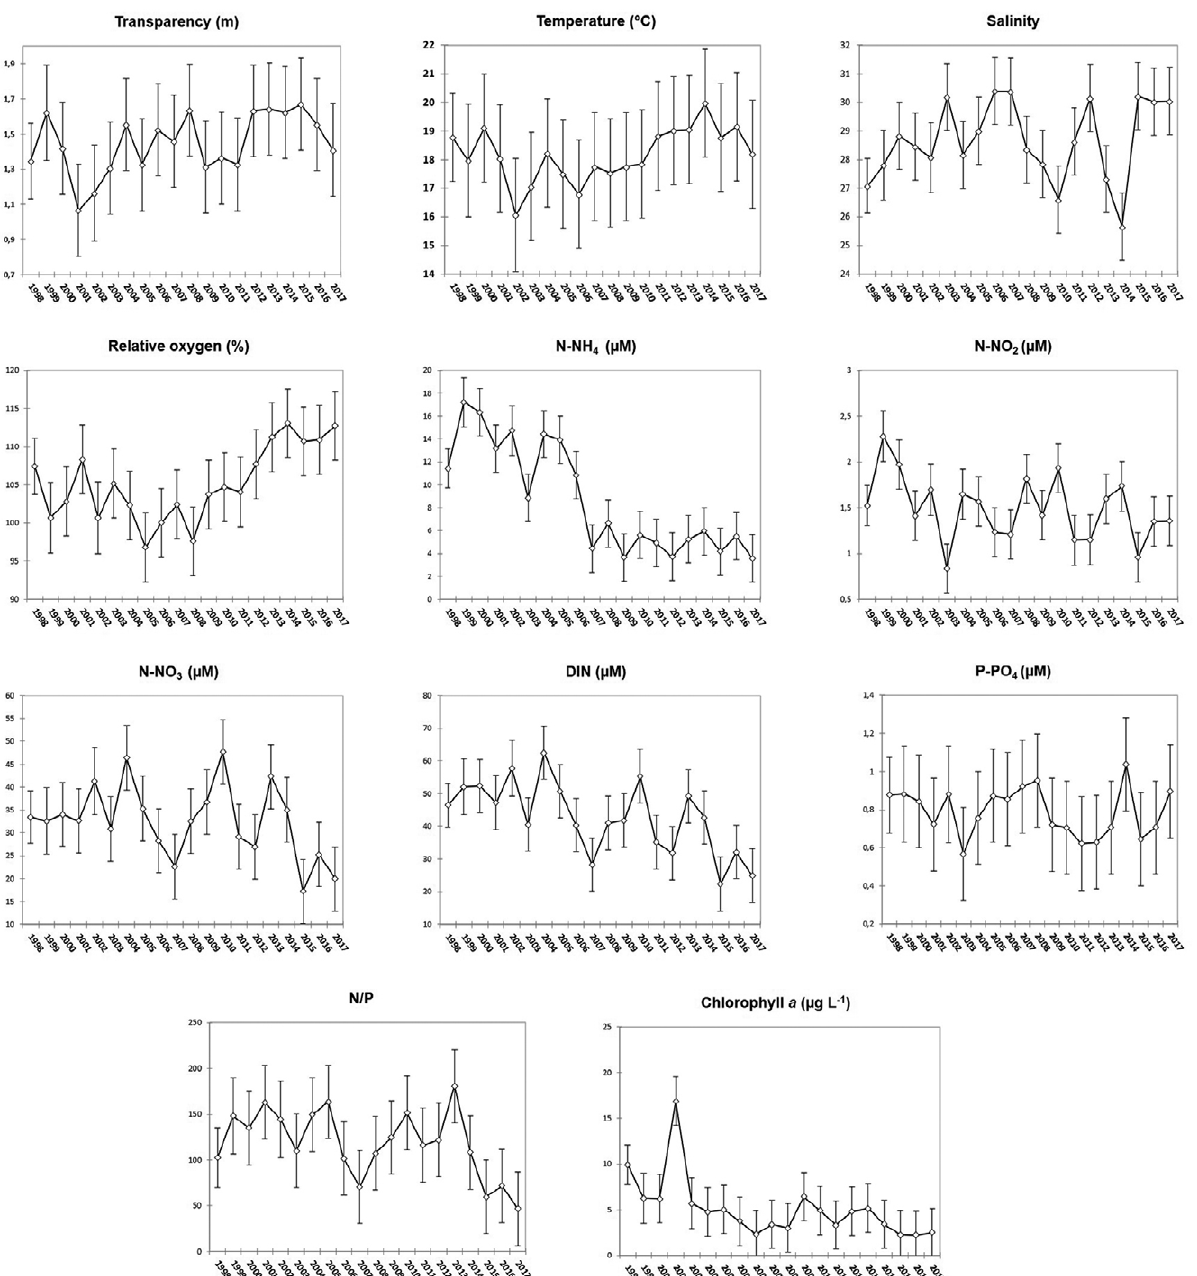
Fig. 2. – Hydrochemical parameters: yearly averages and confidence